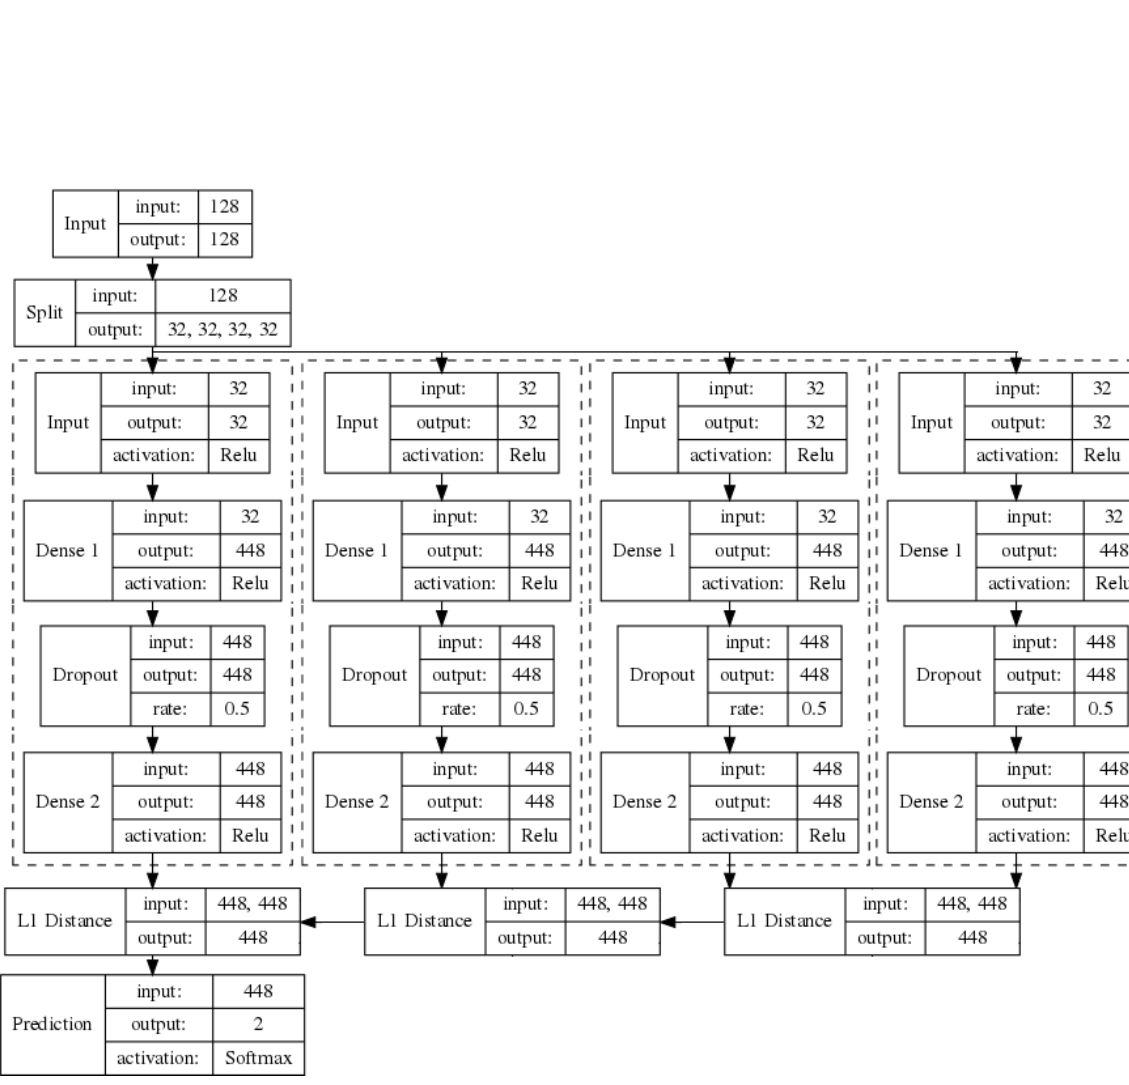
Figure 11: SNN used to learn PUF s using XOR-equations derived by SPC, BCH and RM codes. During training the loss is calculated using sparse categorical cross entropy. The chosen optimizer is Adam with default parameters and a learning rate of 0 .